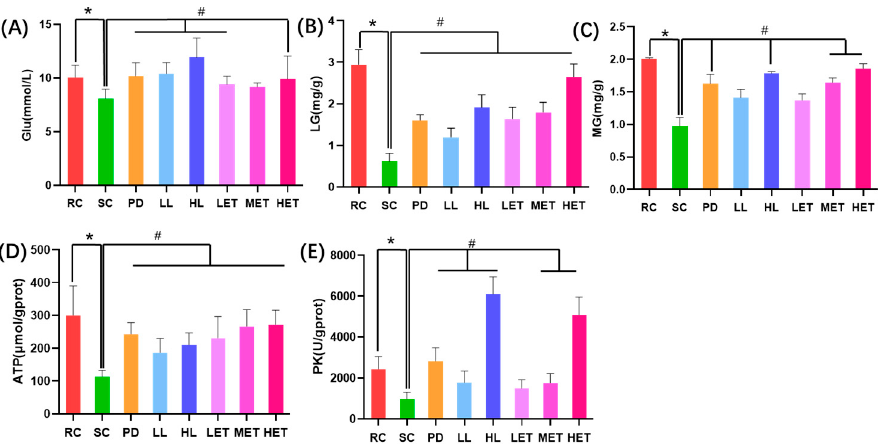
Figure 7. Regulation by LBP and LBPT of energy metabolism. ( A ) blood Glu; ( B ) liver glycogen contents, LG; ( C ) muscle glycogen contents, MG; ( D ) muscle ATP; and ( E ) Muscle PK. Data are expressed as mean ±SD, N = 8, *: vs. RC p < 0.05, #: vs. SC, p < 0.05.